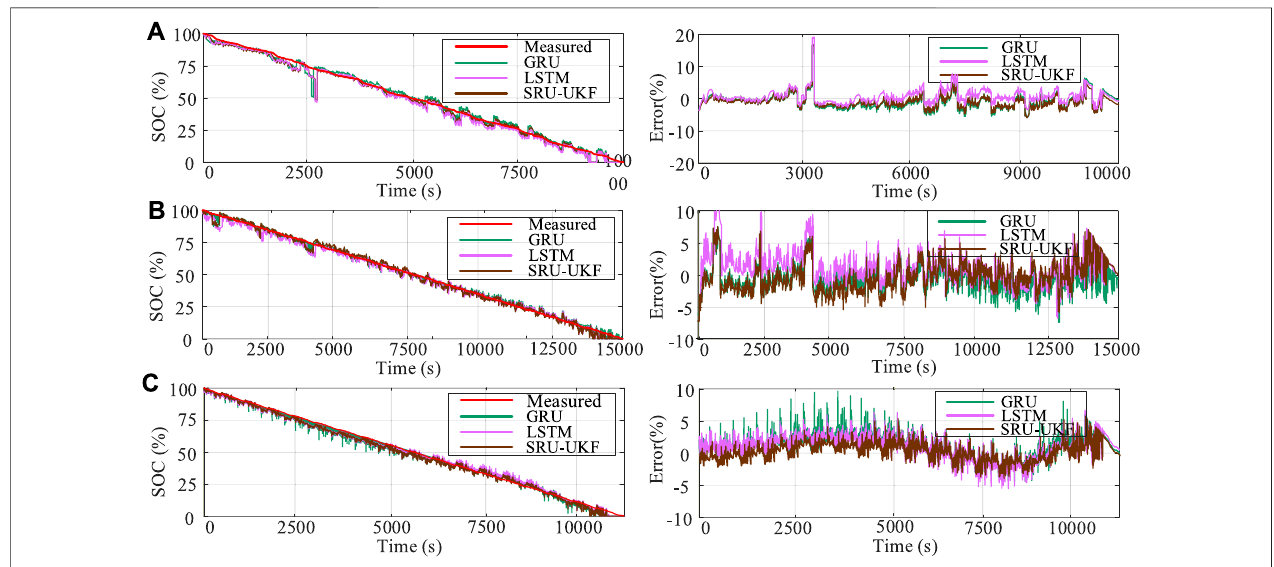
FIGURE 10 | Performance of GRU, LSTM, and SRU – UKF models against three drive cycles: (A) FTP, (B) LA92, and (C) US06.